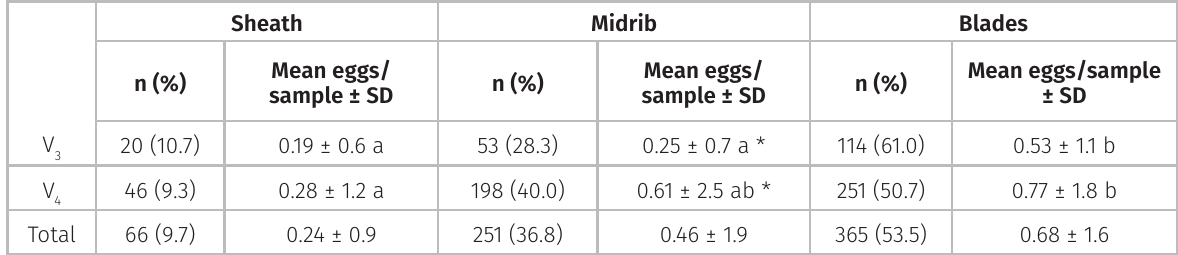
Table SIX). Thus, variation in the emergence of the different wasp species did not depend on the distribution of eggs in the leaf. These results suggest the spatial segregation and/or higher